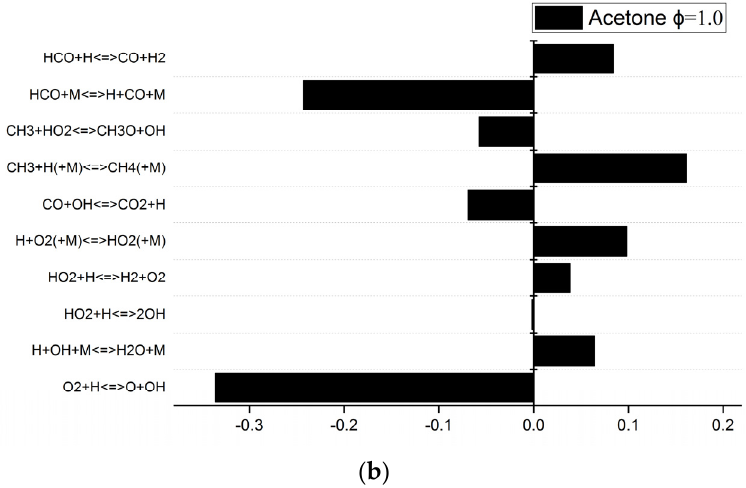
Figure 9. Sensitivity analyses of mixed fuel ETAC31 at 𝜙 = 1.0 (( a ) ethanol, ( b ) acetone).